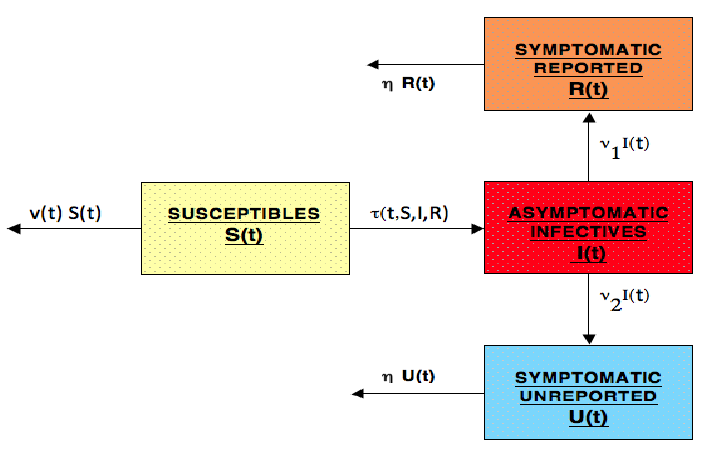
Figure 1. Flow diagram of the model compartments: susceptible, asymptomatic infected, reported symptomatic infected, and unreported symptomatic infected. The time units are days.